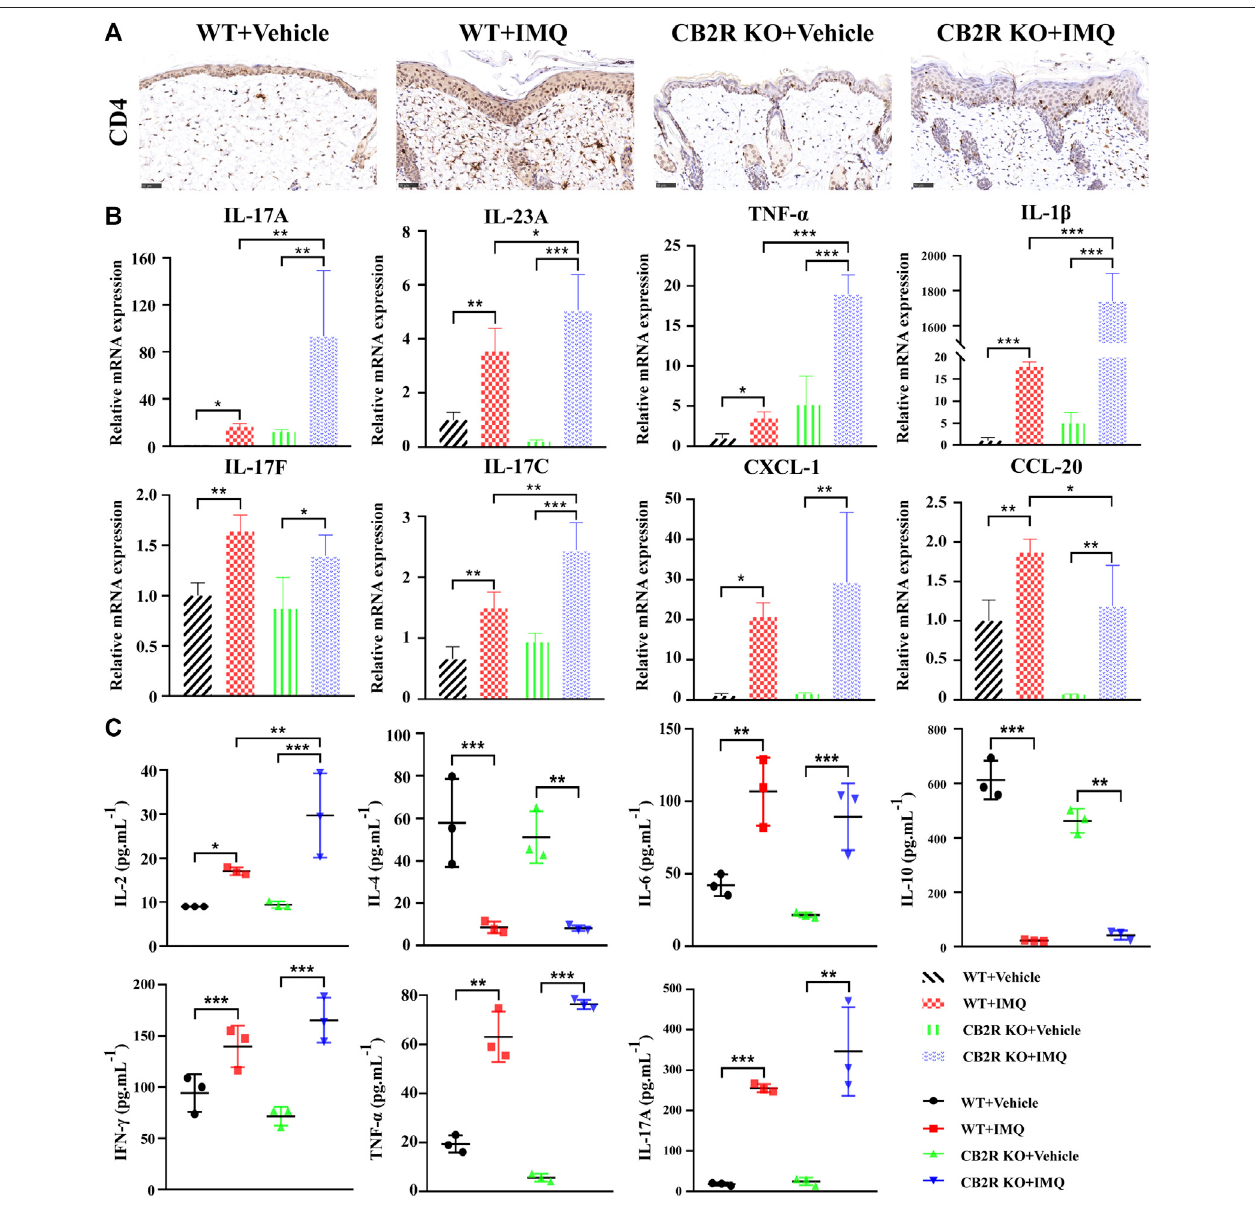
FIGURE 2 | Effects ofCB2R on the in fi ltration of CD4 + T cell and expression levels of in fl ammatory cytokines in micewith IMQ-induced psoriasiform dermatitis. (A) TherepresentativeimmunohistochemicalstainingimagesofIMQ-andvehicle-treatedskininWTandCB2RKOmiceatday7.Scalebarrepresents50 μ m. (B) Real-time quantitative PCR was performed to quantify the mRNA level of IL-17A, IL-23A, TNF- ɑ , IL-1 β , IL-17F, IL-17C, CXCL-1, CCL-20 in the skin biopsies from mice. Data are obtainedfromduplicatesamplesfrom fi vemiceineachgroup. (C) CBAassaywasperformedtoquantifytheproteinlevelofIL-2,IL-4,IL-6,IL-10,IFN- γ ,TNF- ɑ and IL-17Ain the serum from mice. All the assays were repeated three times with consistent results. Error bars represent mean ±SD. * p < 0.05, ** p < 0.01, and *** p < 0.001 when compared.